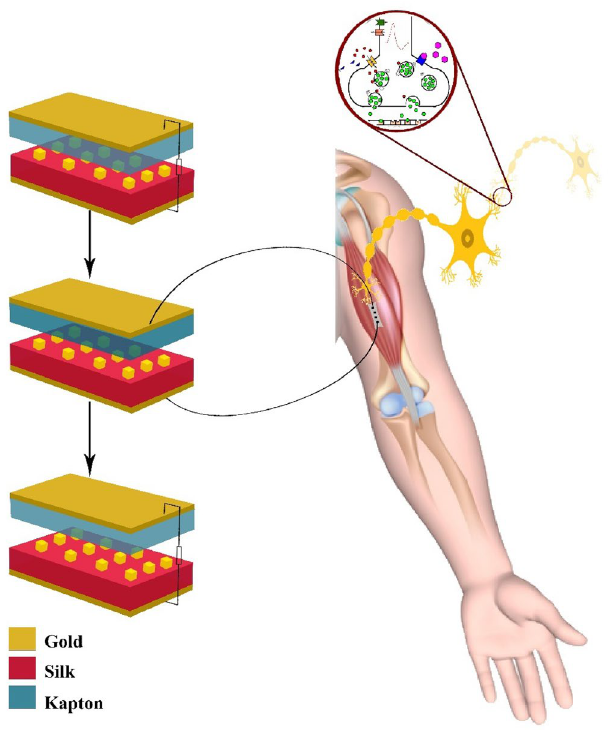
Figure 1. Schematic diagram of the operating TENG and electrical stimulation of the neuron.